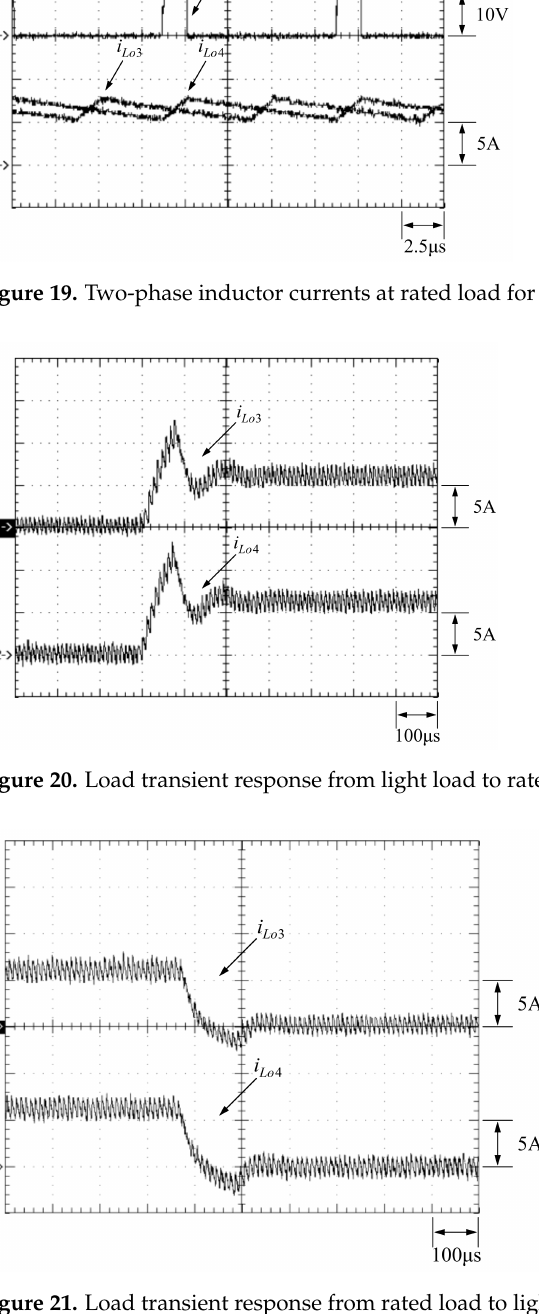
Figure 21. Load transient response from rated load to light load for the second secondary